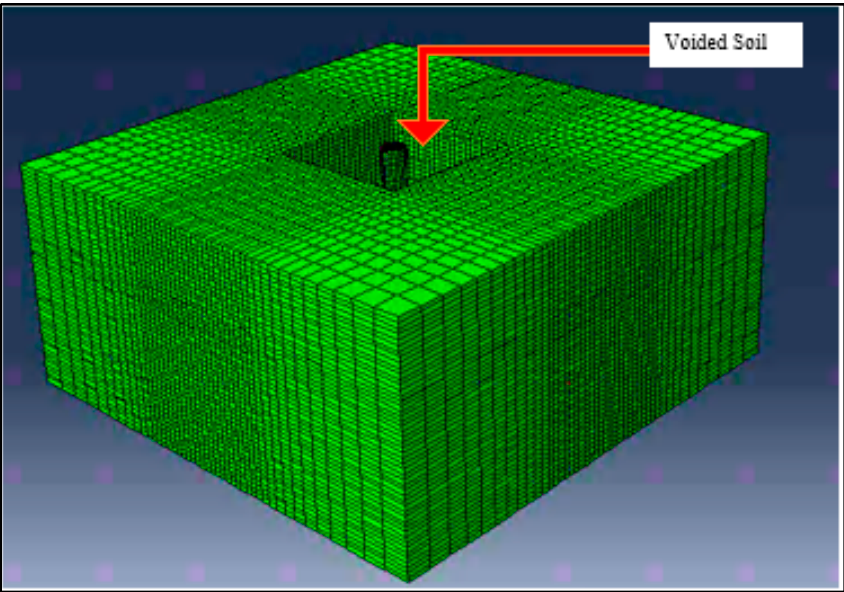
Figure 10. Three-dimensional Abaqus model showing scour case 1 (voided area indicates scour hole). Alternatively, the scour problem could be solved by specifying user defined variables, such as stress state of failure, to automatically remove the